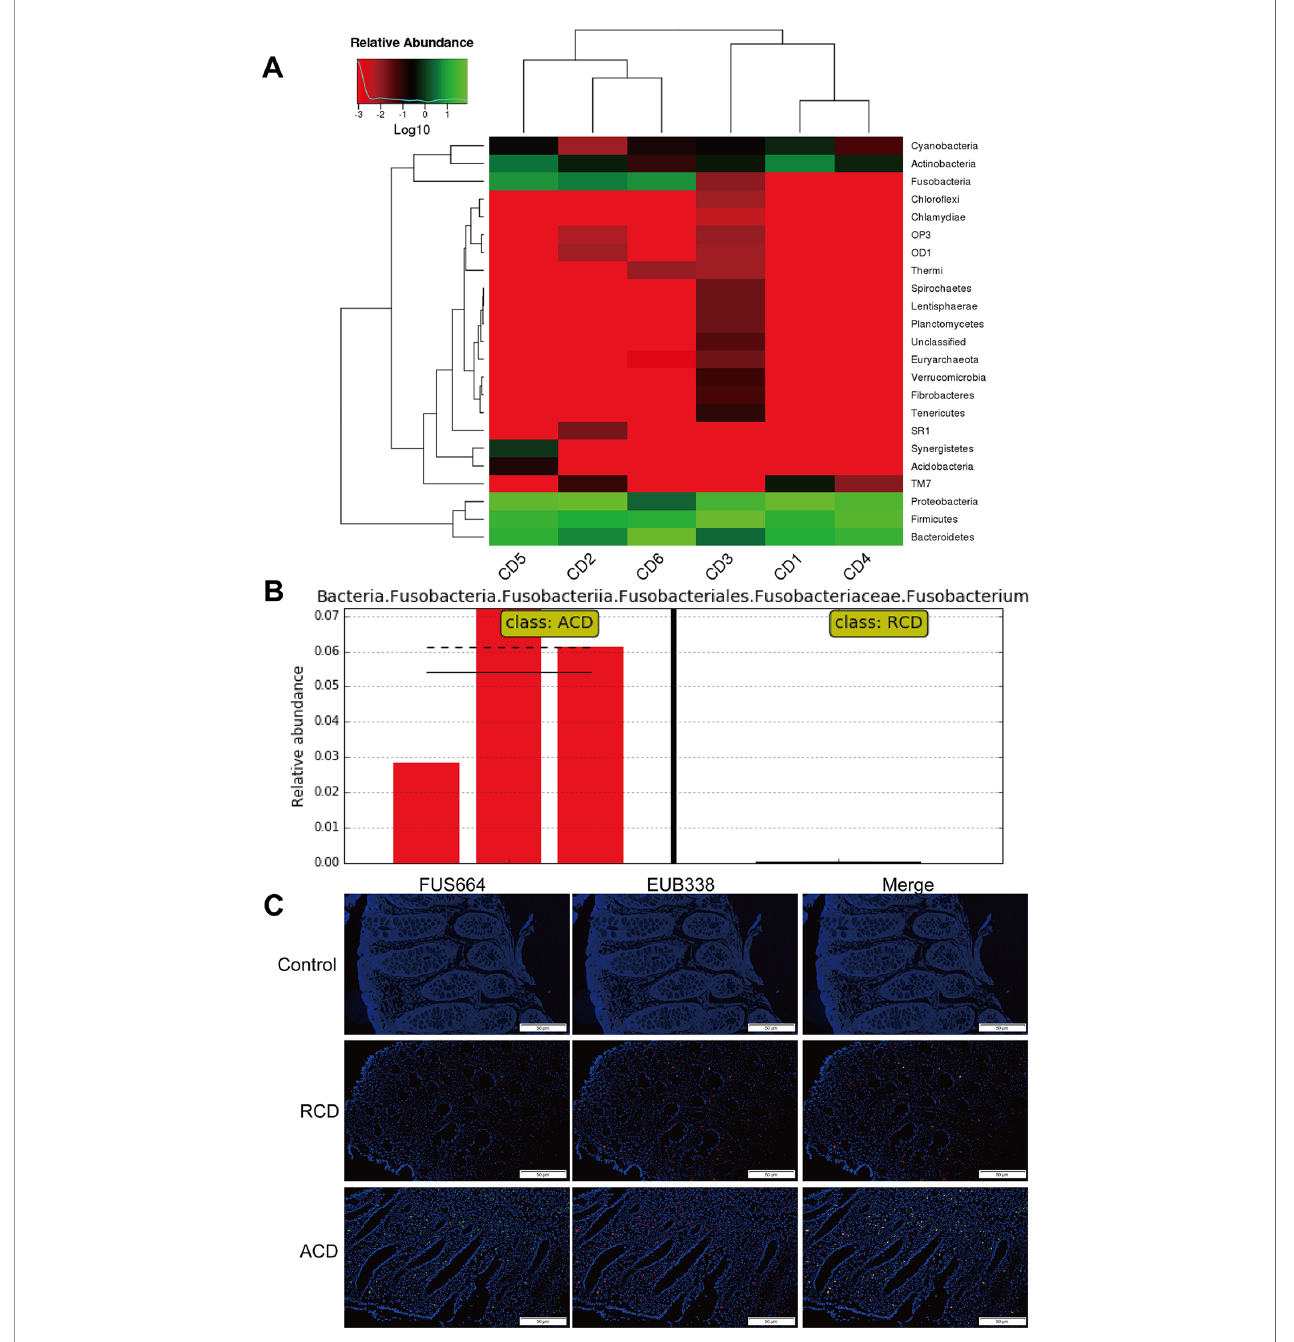
FIGURE 1 | Fusobacterium nucleatum is associated with Crohn ’ s disease (CD) activity. (A) Hierarchically clustered heat map representing bacterial taxa (genus level) in six CD tissues from patients [active CD (ACD) = 3, remitted CD (RCD) = 3] by 16S rDNA sequencing. The relative percentages of bacteria are indicated by varying color intensities. Species with an abundance of less than 0.5% in all samples were classi fi ed as “ Others. ” ACD: CD2, CD5, CD6; RCD: CD1, CD3, CD4. (B) The LEfSe algorithm was used to identify Fusobacterium in ACD and RCD tissues from patients. (C) Representative fl uorescence in situ hybridization (FISH) images to assess the F. nucleatum abundance in ACD (n = 22), RCD (n = 11), and healthy tissues (n = 10). EUB338 (red) is a Cy3-conjugated universal bacterial oligonucleotide probe; FUS664 (green) is a fl uorescein isothiocyanate (FITC)-conjugated F. nucleatum- speci fi c oligonucleotide probe. Magni fi cation, 200×. The sequence of the FITC-labeled Fn-targeted probe, FUS664, was: 5 ′ - CTT GTA GTT CCG C(C/T) TAC CTC -3 ′